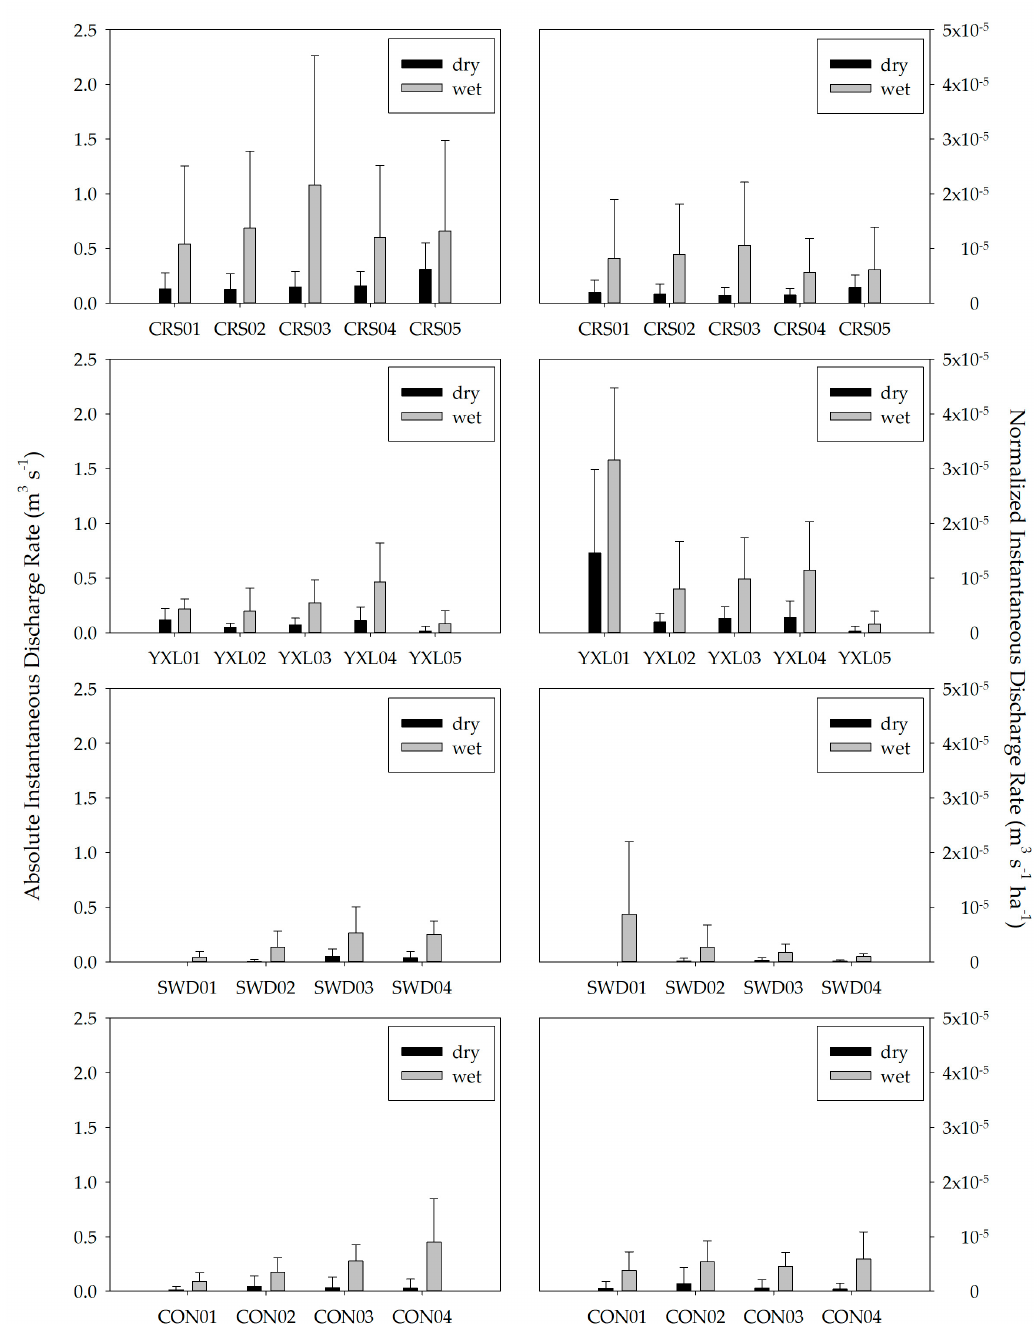
Figure 5. Seasonal mean (+/ − 1 std dev) of absolute and normalized (by catchment area) discharge rates for the study catchments.